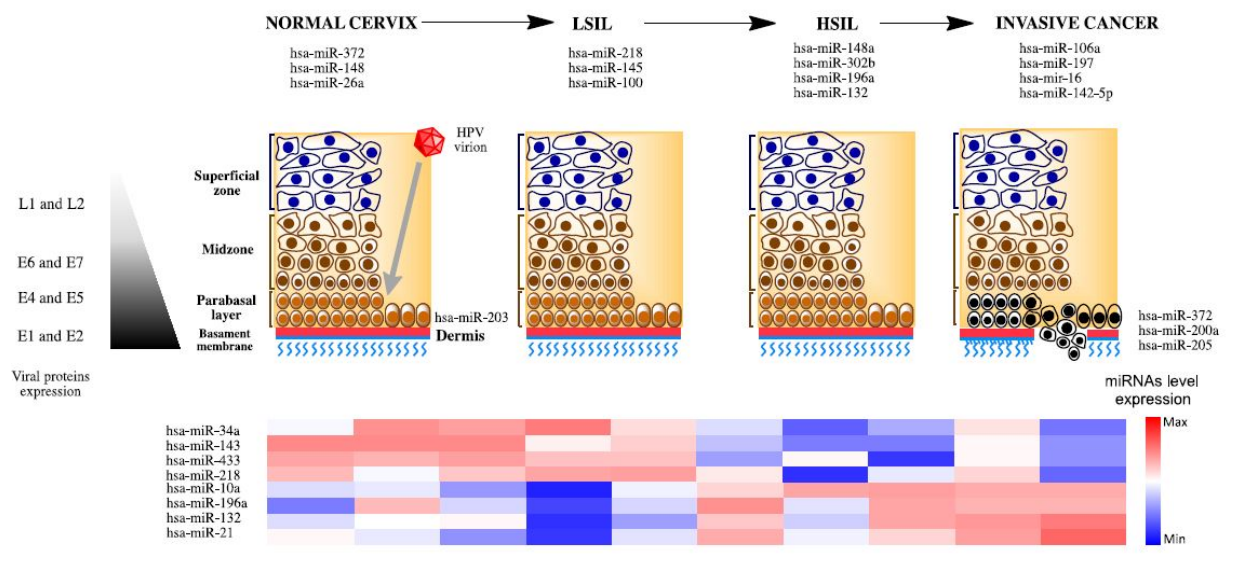
papillomavirus infects epithelial basal cells through mechanical microabrassions or by infecting directly the transformation zone, an abrupt transition from columnar to squamous epithelium. Infected parabasal cells actively express the early genes E1, E2, E4, and E5, E6 and E7 are expressed in limited quantities due to transcriptional modulation exerted by E2, which allows cells to have a higher cell-cycle progression. Infected basal cells migrate to the lumen as they differentiate expressing the late capsid genes L1 and L2. Several premalignant lesions (low and high grade squamous intraepithelial lesion, LSIL and